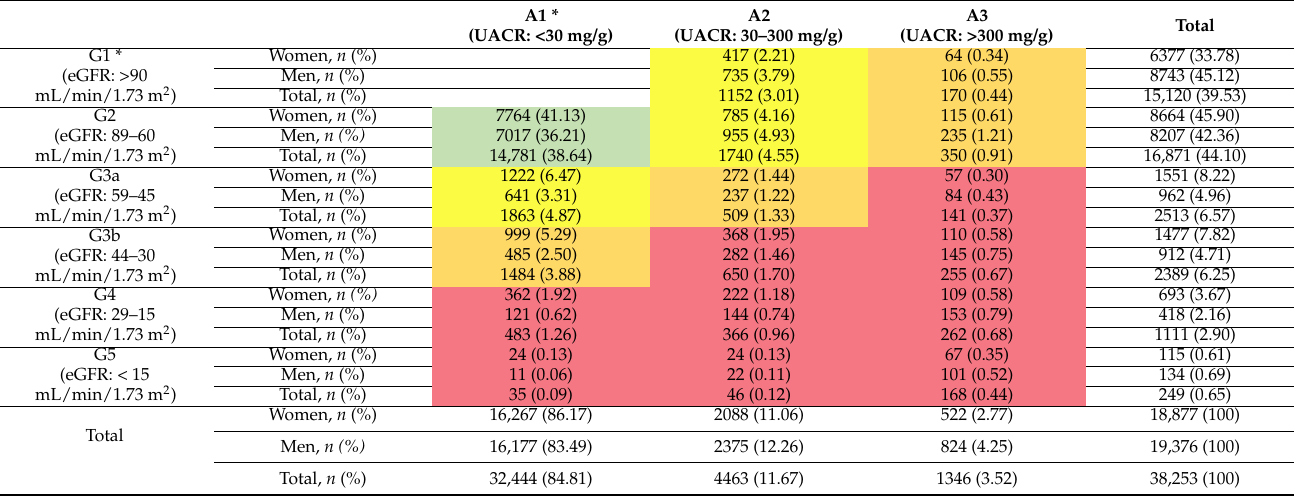
Table 2. Estimation of risk levels according to eGFR and UACR data of the 38,253 patients for which two eGFR and UACR values were available separated by at least 3 months. The colors indicate the risk of global mortality, cardiovascular mortality, kidney failure treated with dialysis or transplantation, acute kidney failure and progression of kidney disease [11,16]: green , low risk (if no other markers of kidney disease, no CKD); yellow , moderately increased risk; orange , high risk; red , very high